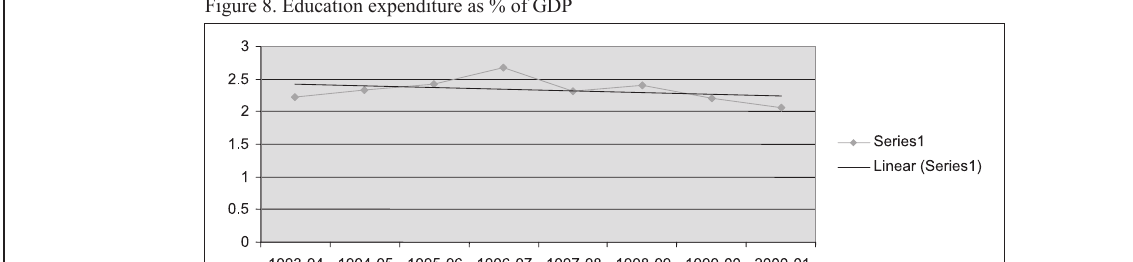
Figure 8. Education expenditure as % of